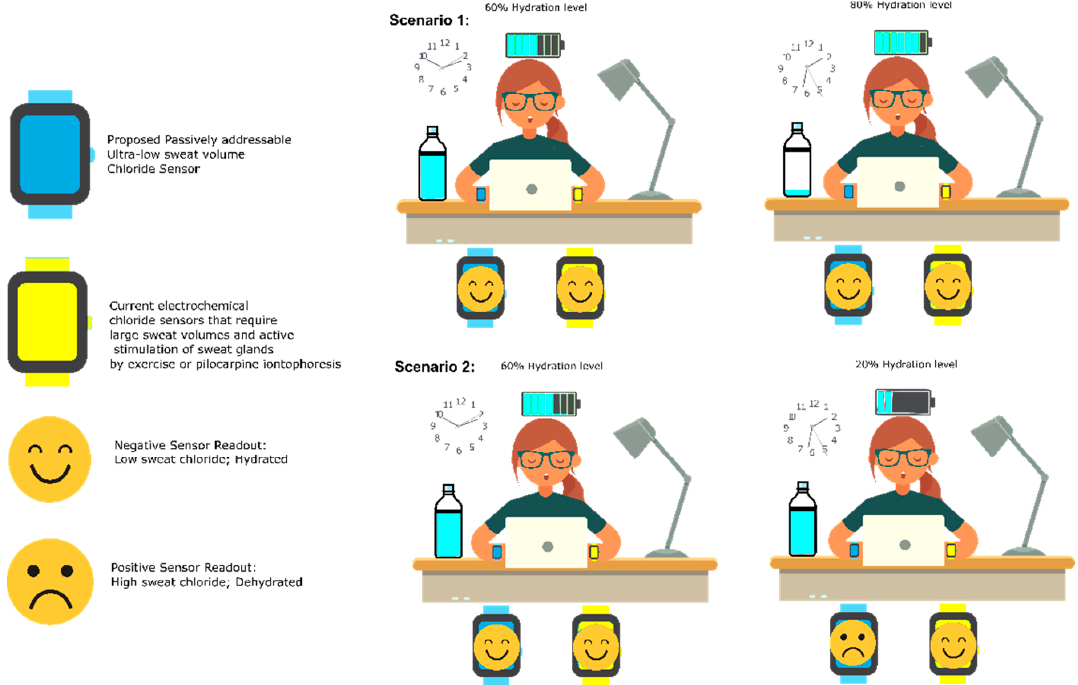
Figure 1. The proposed sensor requires sweat volumes related to natural sweating rates under normal ambient conditions; it has superior sensitivity compared to the currently available sweat chloride-sensing